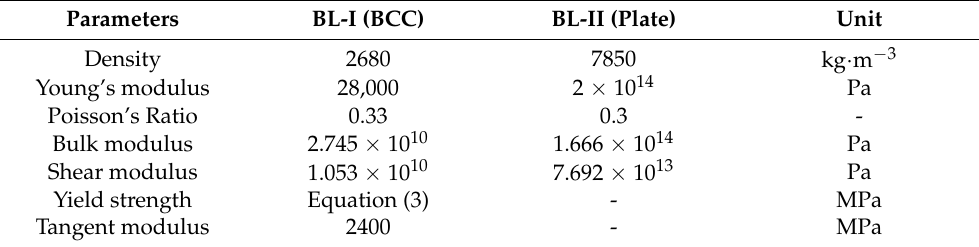
Figure 14. ( a ) Definition of the variable parameter YST, based on the nominal lattice structure diameter. ( b ) The results of the mechanical test used for calibration of the FEM models. ( c ) Comparison of the experimental and calibrated FEM results on thin lattice structure ( d = 0.6 mm). ( d ) Comparison of the experimental and calibrated FEM results on thin lattice structure ( d = 1.5 mm). Table 6. Material model parameters used for lattice structures’